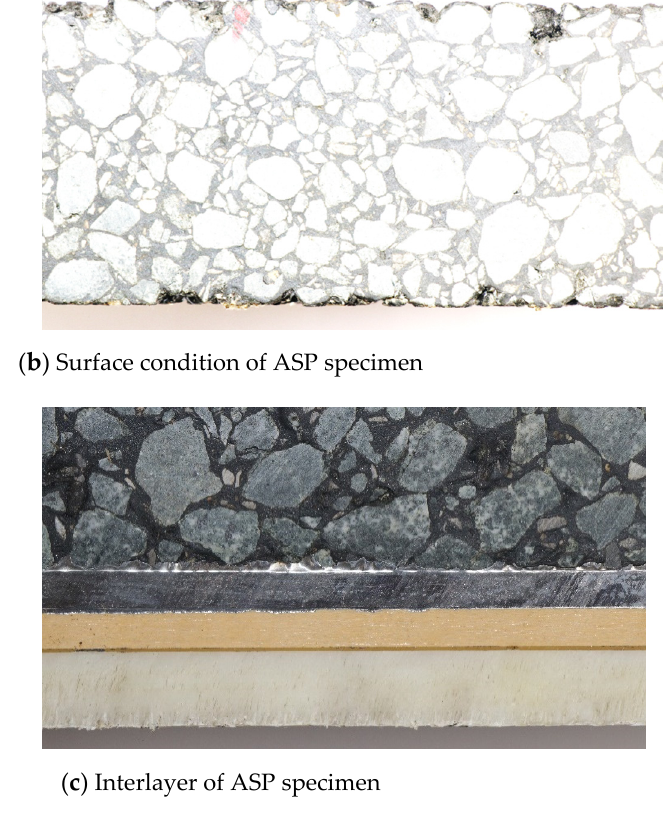
Figure 17. Surface condition of SMA and ASP specimens after loading.